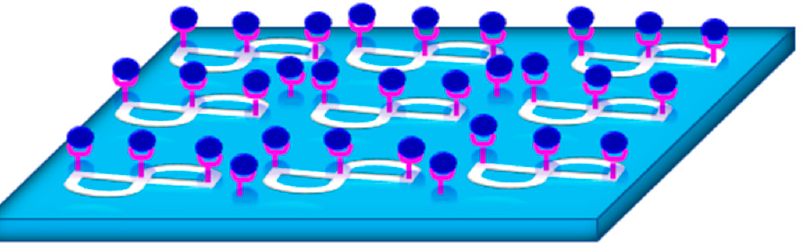
Figure 16. Schematic diagram of ZIKV envelope protein binding with their matching antibodies on toroidal THz plasmonic